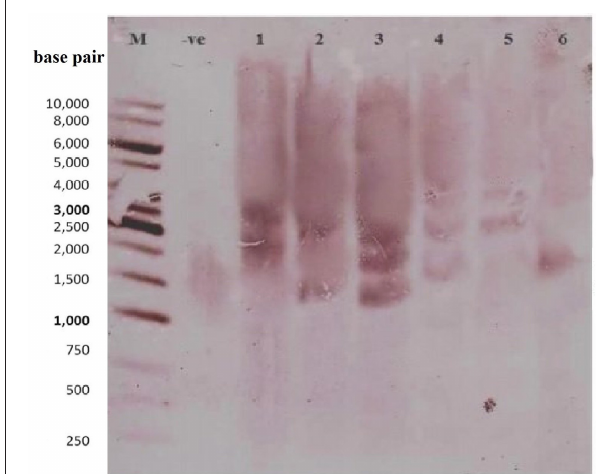
FIGURE 4 | Determination of copy number of transgene (Fiber Gene GhEXPA8 ) through southern blot analysis. Lane M: 1kb DNA Ladder, Lane 1: Negative Control (DNA of untransformed plant), Lane 2–7 (FG-8-1, FG-8-4, FG-8-5, FG-8-11, FG-8-13, and FG-8-15 respectively): Selected Transgenic Cotton Plant Samples (pGA482- GhEXPA8 ) were digested with EcoR1, probed with biotin-labeled GhEXPA8 DNA to assess copy number of